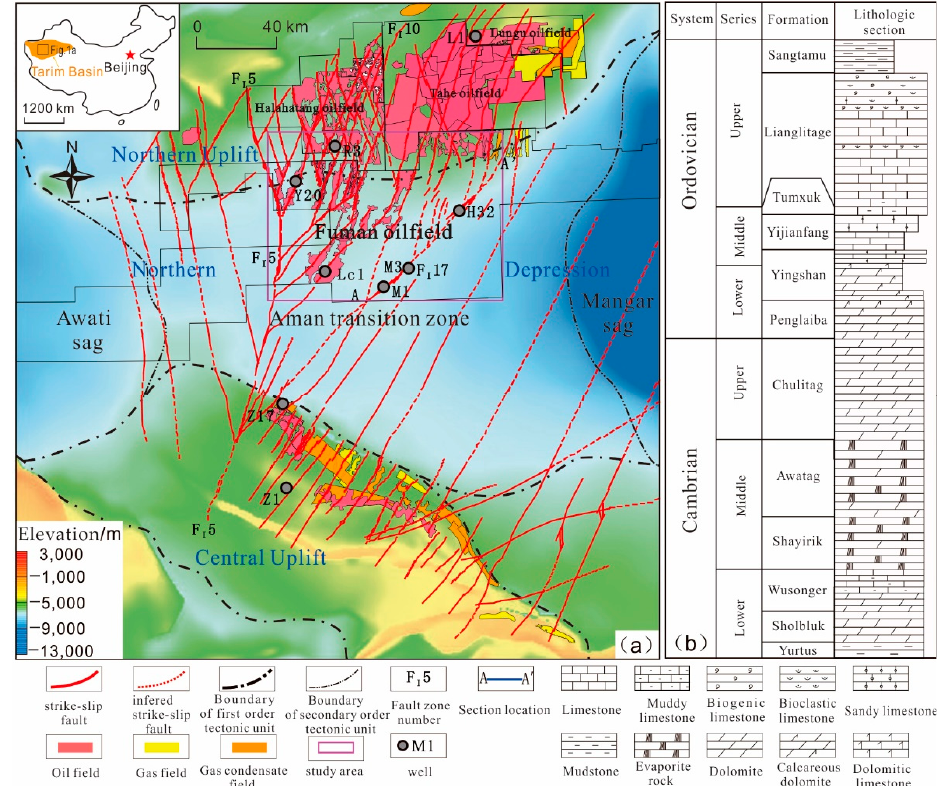
Figure 1. ( a ) The strike-slip fault system in the Ordovician carbonates (the figure at the top left corner showing the location of Figure 1a in the Tarim Basin) and ( b ) the Cambrian–Ordovician stratigraphic column in the Tarim Basin (The strike–slip fault zones are mapped by 3D seismic data, the color base map showing the topography of the top of the Ordovician carbonate; the oil/gas distribution and tectonic sketch appear after the reference [16]).